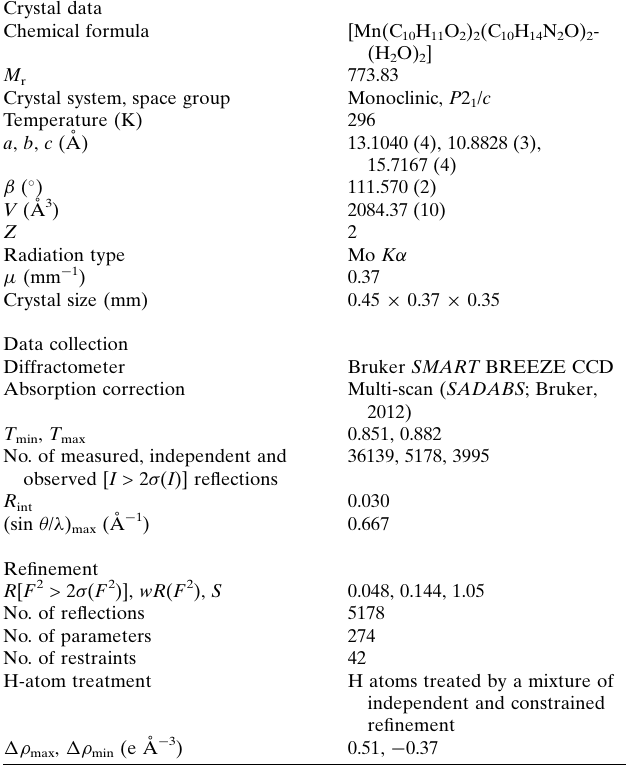
Table 3 Experimental details. Crystal data Chemical